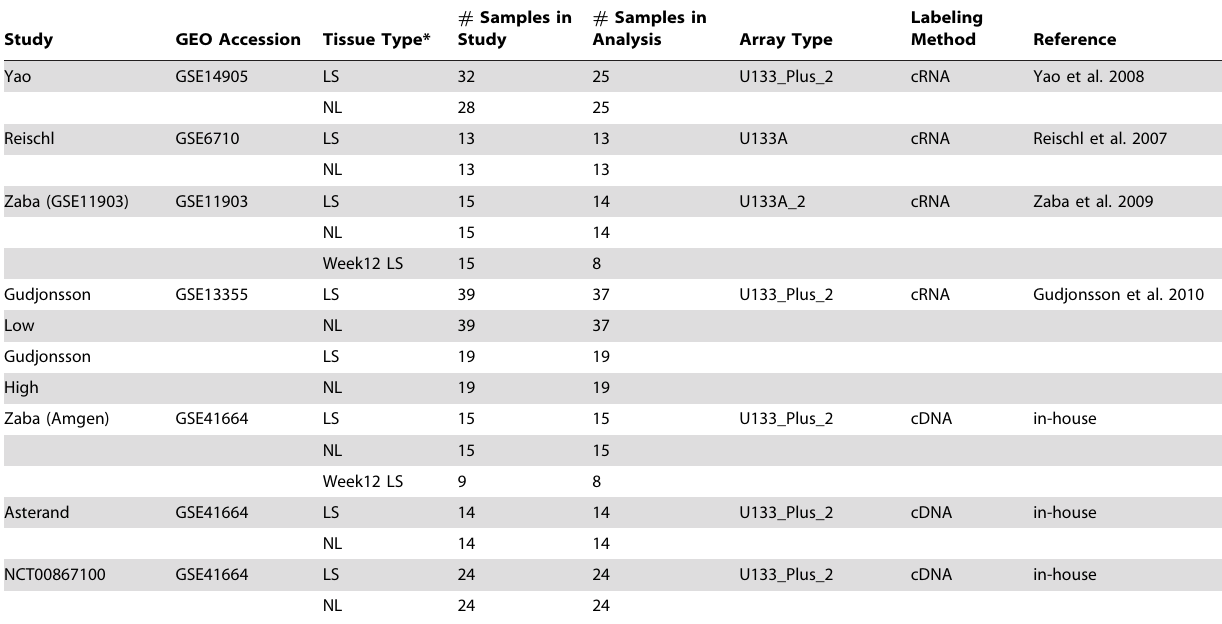
Table 1. Psoriasis Data